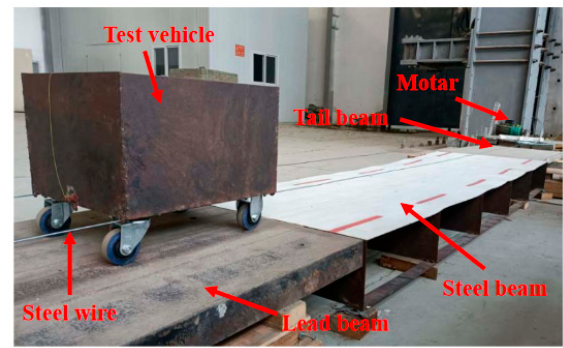
Figure 14. The whole experimental model.